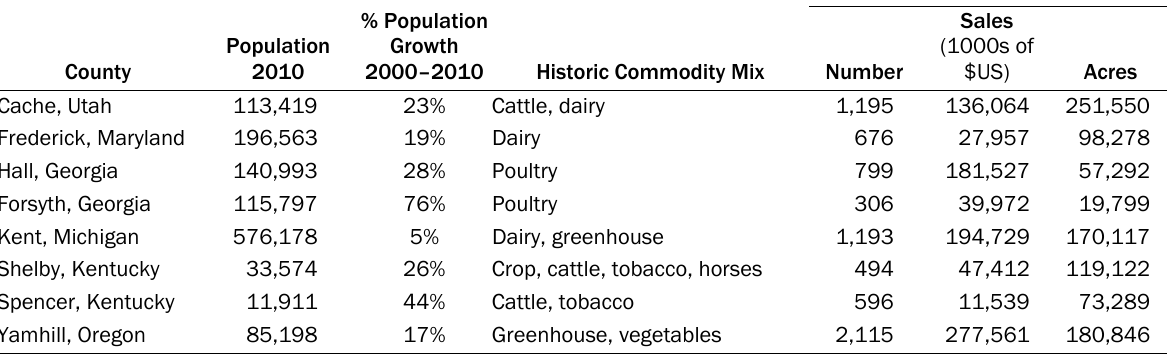
Table 1. Study Counties